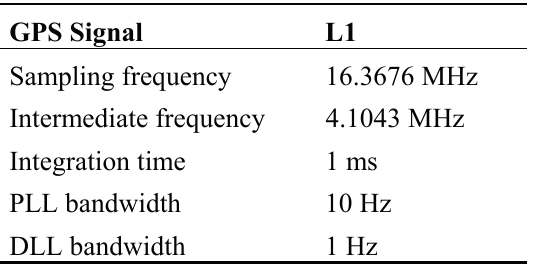
Table 1. Parameters of front end and GPS software